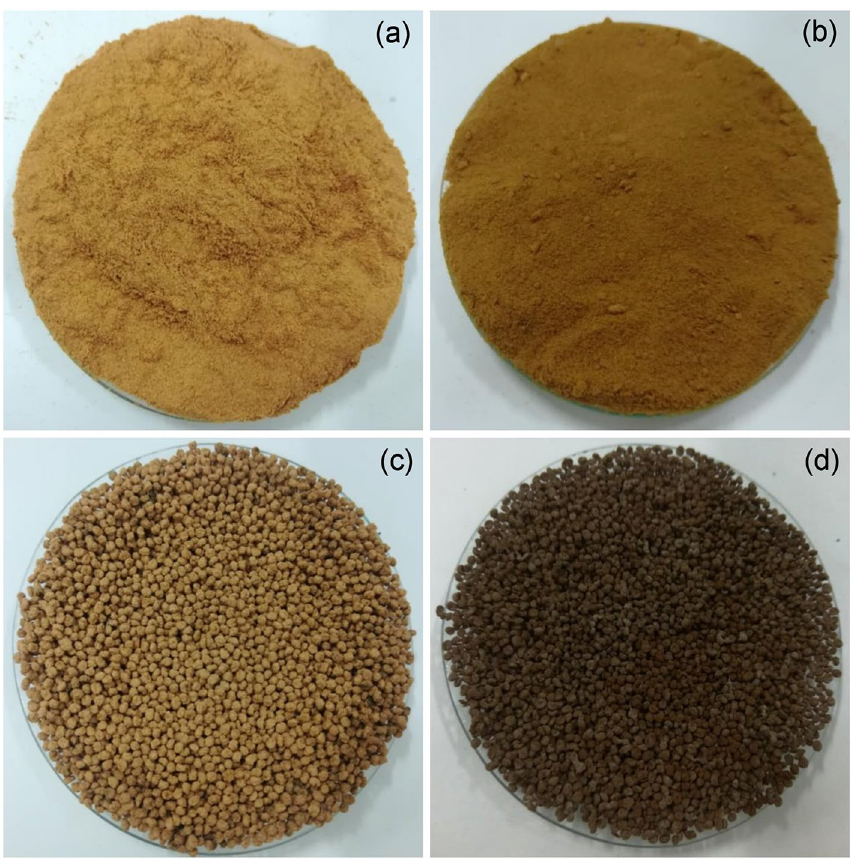
Figure 1. The physical characteristics of ( a ) sawdust powder (SP), ( b ) sawdust powder doped iron (III) oxide- hydroxide (SPF), ( c ) sawdust beads (SPB), and ( d ) sawdust powder doped iron (III) oxide-hydroxide beads